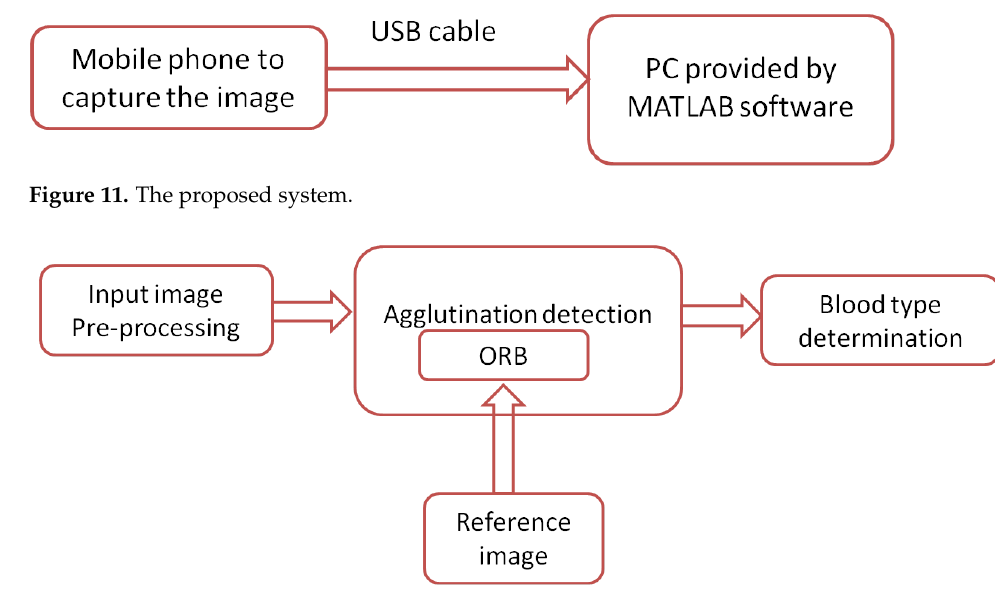
Figure 12. Software processing steps.